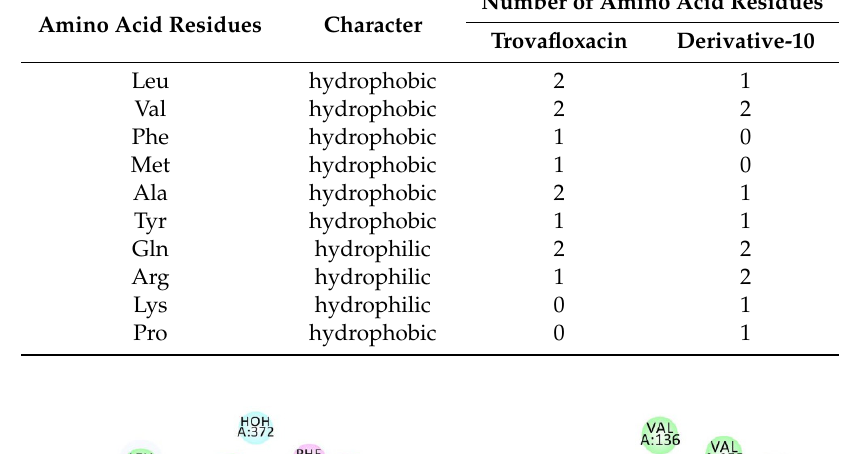
Table7. Thenumberofhydrophilic / hydrophobicaminoacidresiduethattrovafloxacinandderivative-10 bound to plasma protein.